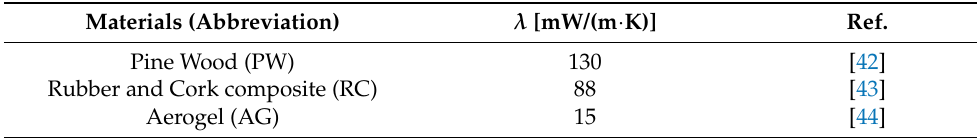
Figure 2. Thermal break strip materials assembled on the LSF partitions.